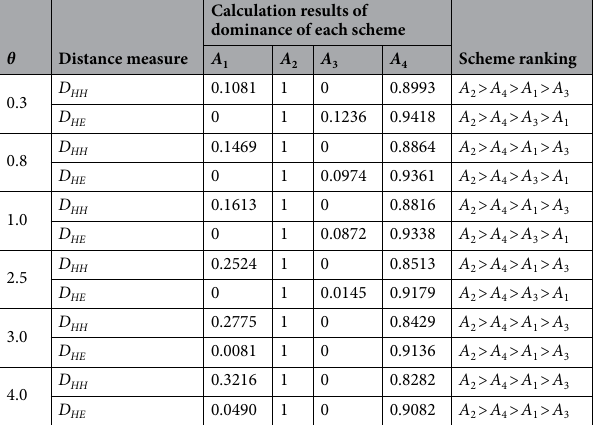
Table 8. Comparison of dominance of alternatives under different θ by two distance measure